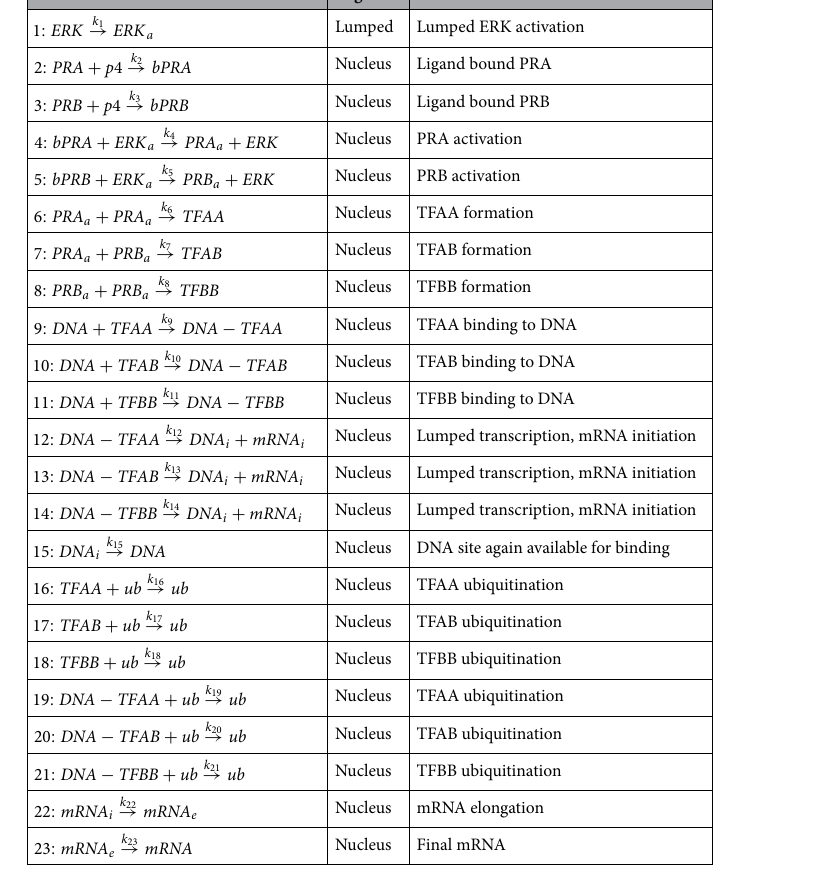
Table 4. Reactions and rates considered in the transcription